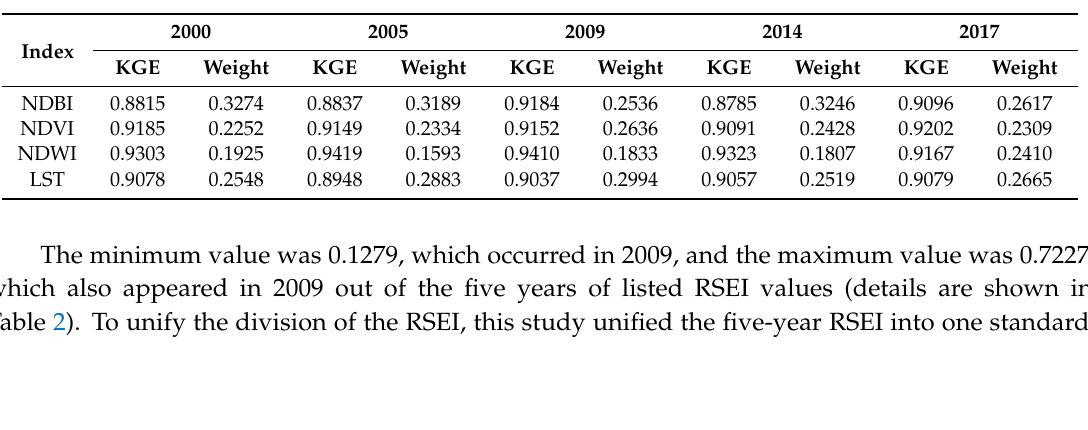
Table 1. Knowledge granulation entropy and weight of the RSEI in China in